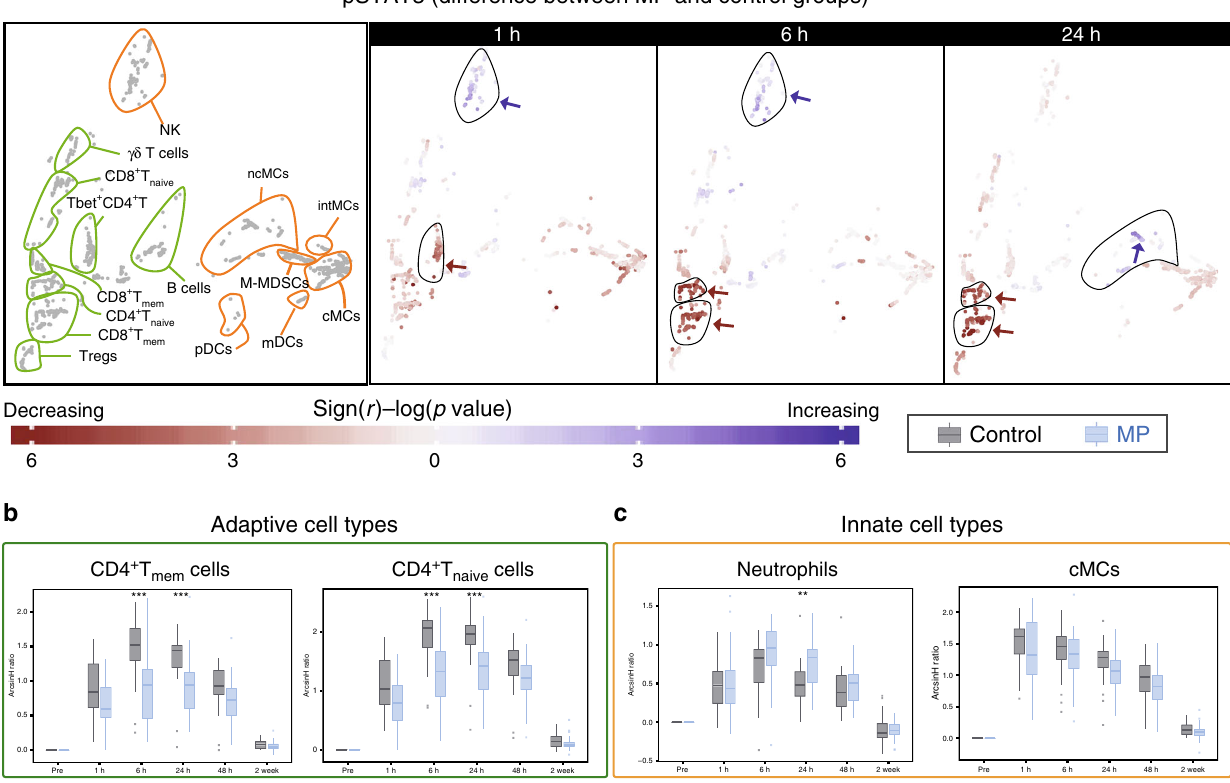
Fig. 4 Alteration of intracellular pSTAT3 responses by MP. a Immune cell atlas depicting differences of the phospho-(p)STAT3 response (arcsinh ratio) between the control ( n = 30 patients) and MP ( n = 28 patients) group at 1, 6, and 24 h after surgery relative to the preoperative time point. Blue/red cluster colors indicate increased/decreased signaling in the MP group, respectively (two-sided Wilcoxon rank-sum test). Arrows point at cell clusters that differ most signi fi cantly between the patient groups. In cell clusters of the adaptive compartment (contoured in green), MP treatment resulted in a sustained attenuation of pSTAT3 responses in CD4 + T cells ( fi rst in Tbet + CD4 + T cells at 1 h, then in CD4 + T naive and CD4 + T mem cells at 6 and 24 h. In contrast, in clusters of the innate compartment (contoured in orange) MP treatment resulted in no signi fi cant changes in the pSTAT3 signal in monocyte subsets (including cMCs, intMCs, and M-MDSCs) and in only a modest increase in the pSTAT3 signal in CD56 lo CD16 + NK cells at 1 and 6 h and ncMCs at 24 h. b , c Box plots depict the pSTAT3 signal in manually gated immune cell subsets corroborating observations contained in the immune atlas. b MP ’ s attenuation of the pSTAT3 signal was most pronounced in CD4 + T cell subsets. c MP does not attenuate the pSTAT3 signal in neutrophils (signal is increased at 24 h) or cMCs. All boxplots show median values, interquartile range, whiskers of 1.5 times interquartile range (two-sided Wilcoxon rank-sum test, * p < 0.01, ** p < 0.001, *** p < 0.0001). Exact p -values are available in Supplementary Table